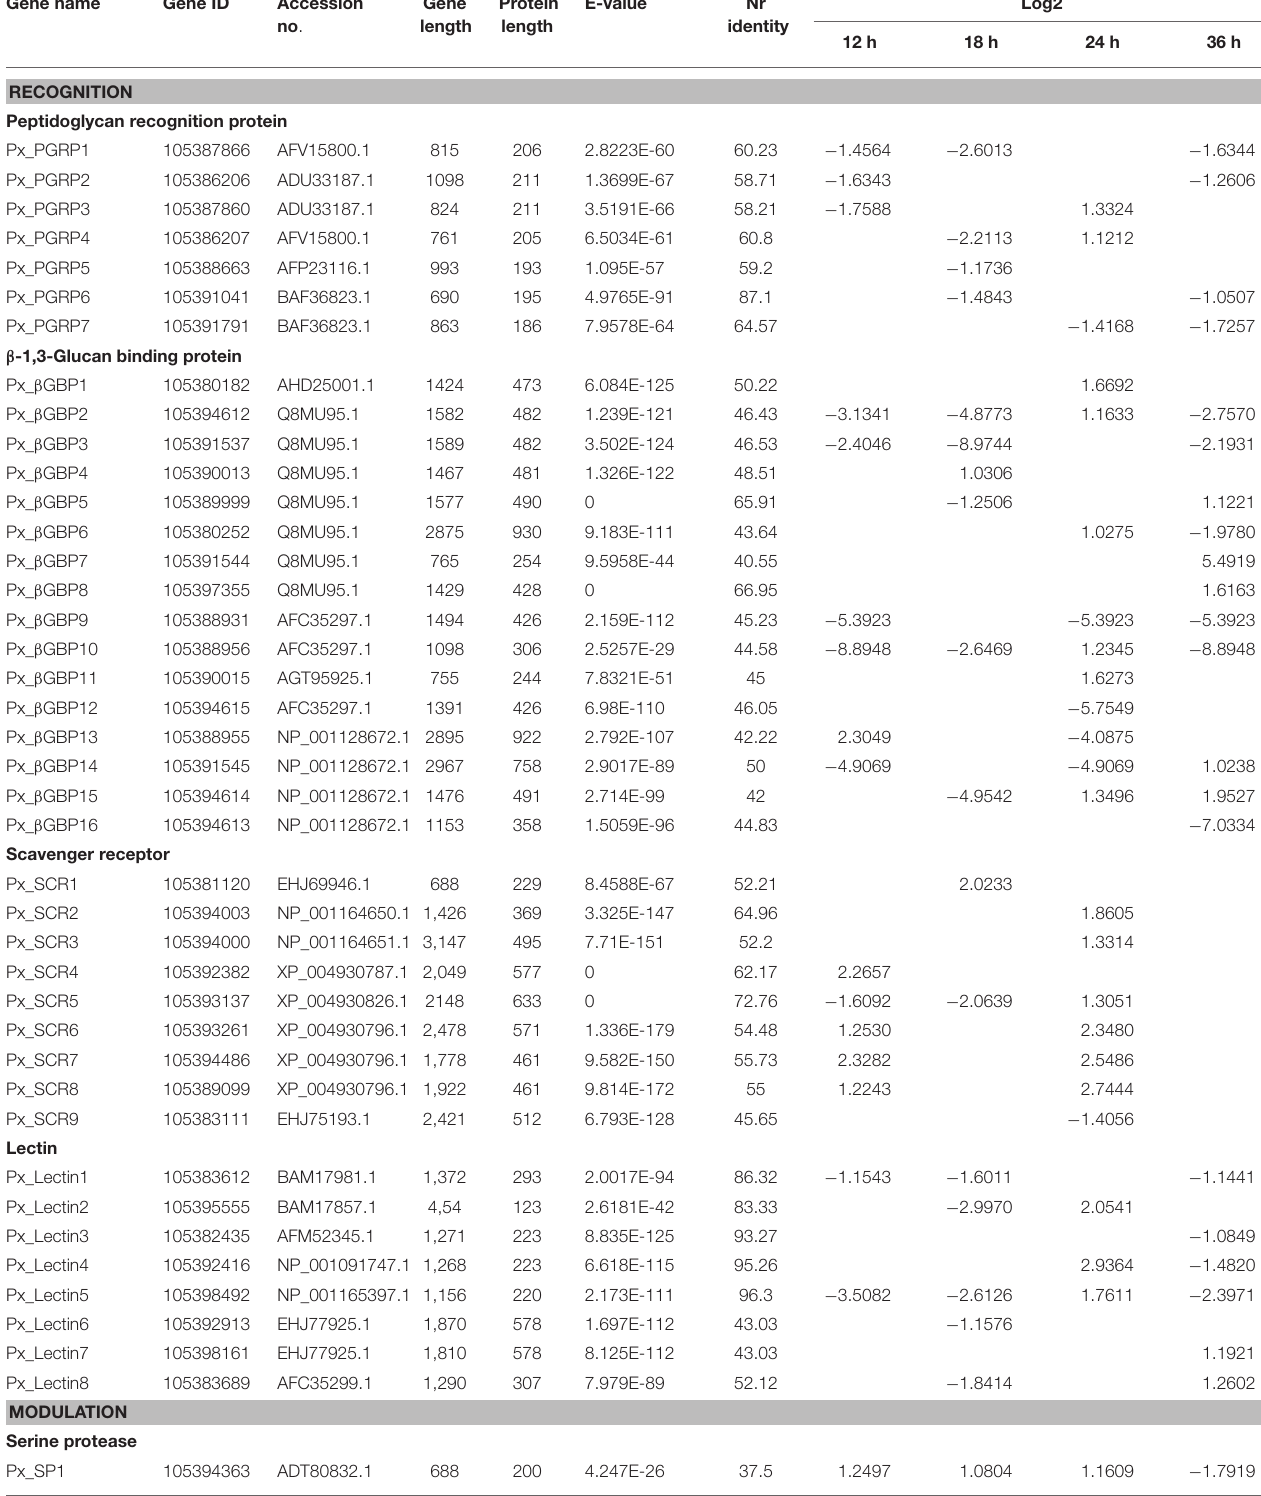
TABLE 3 | Summary of immunity-related genes identified in Plutella xylostella